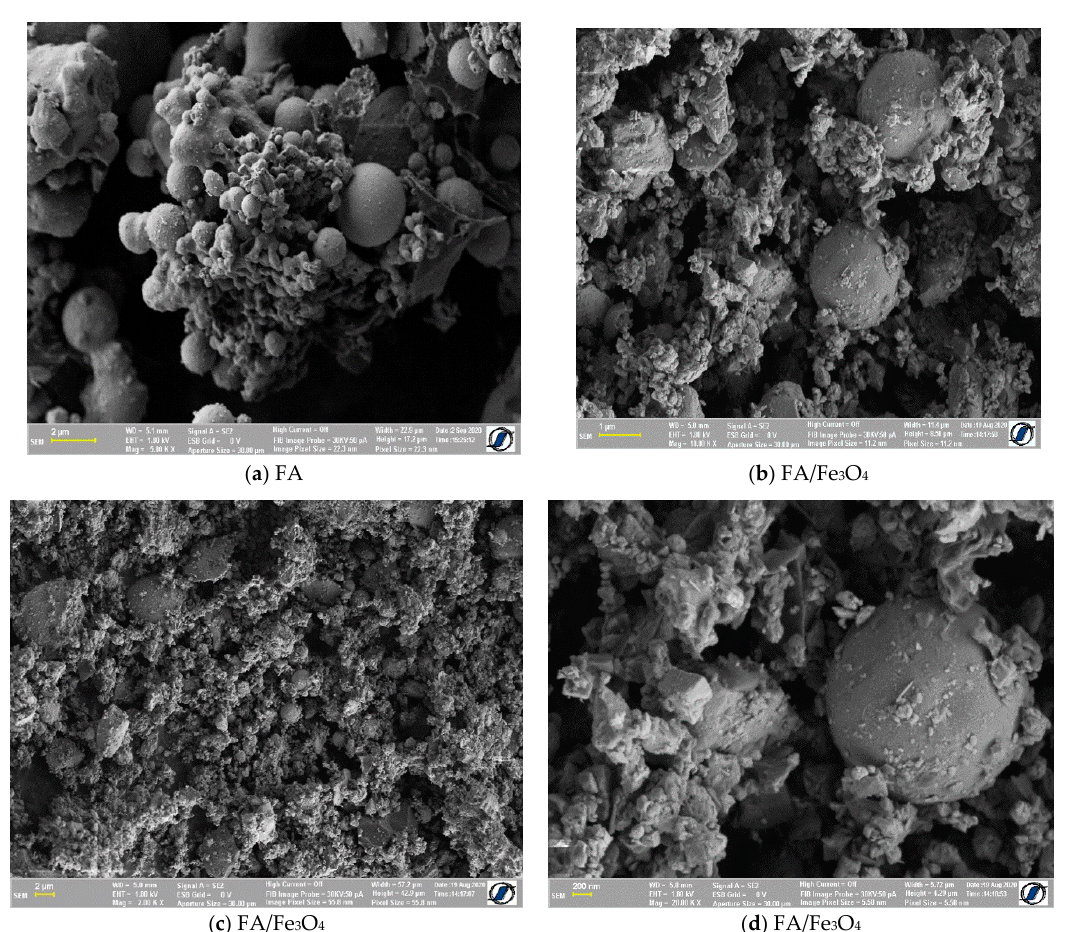
Figure 1. SEM image of the prepared composite.